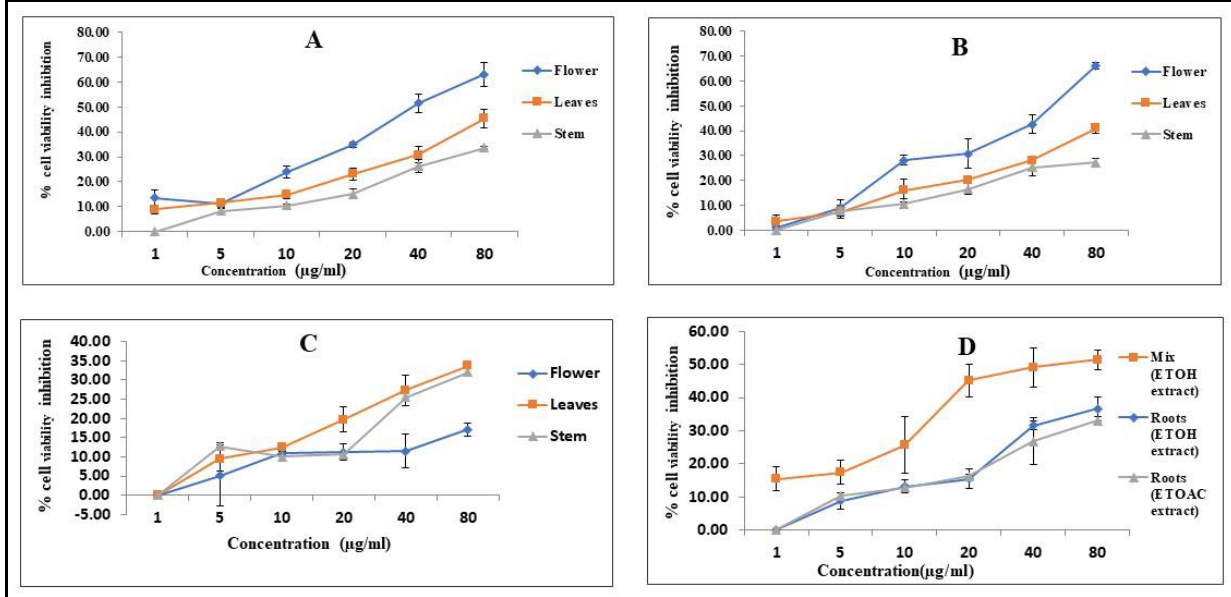
Figure 3. Dosedependent cytotoxicity effects of stem, leaf, and flower on A549 cell line. ( A ) Ethyl acetate extract. ( B ) Ethanolic extract. ( C ) Aqueous extract. ( D ) Ethanolic and ethylacetate extracts of roots and mix (leaves, stem, and flower).